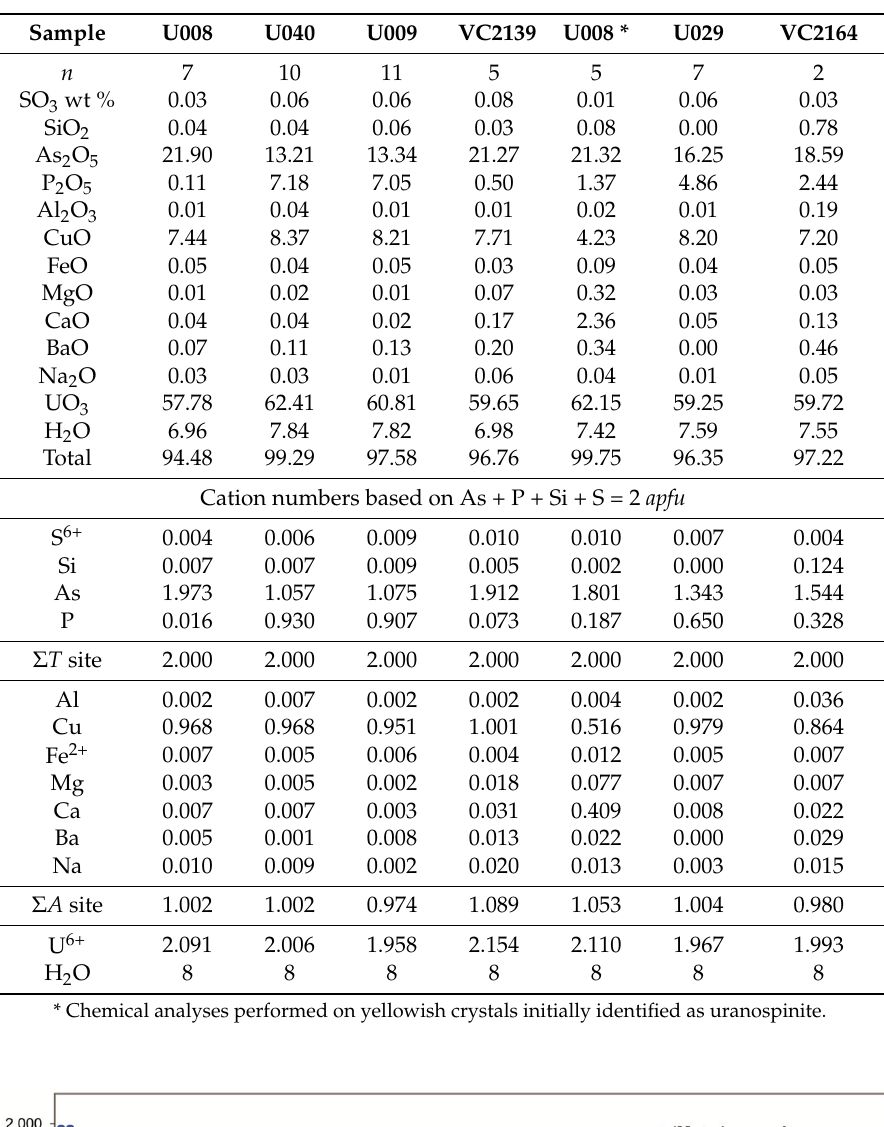
Table 2. Chemical composition of metazeunerite.